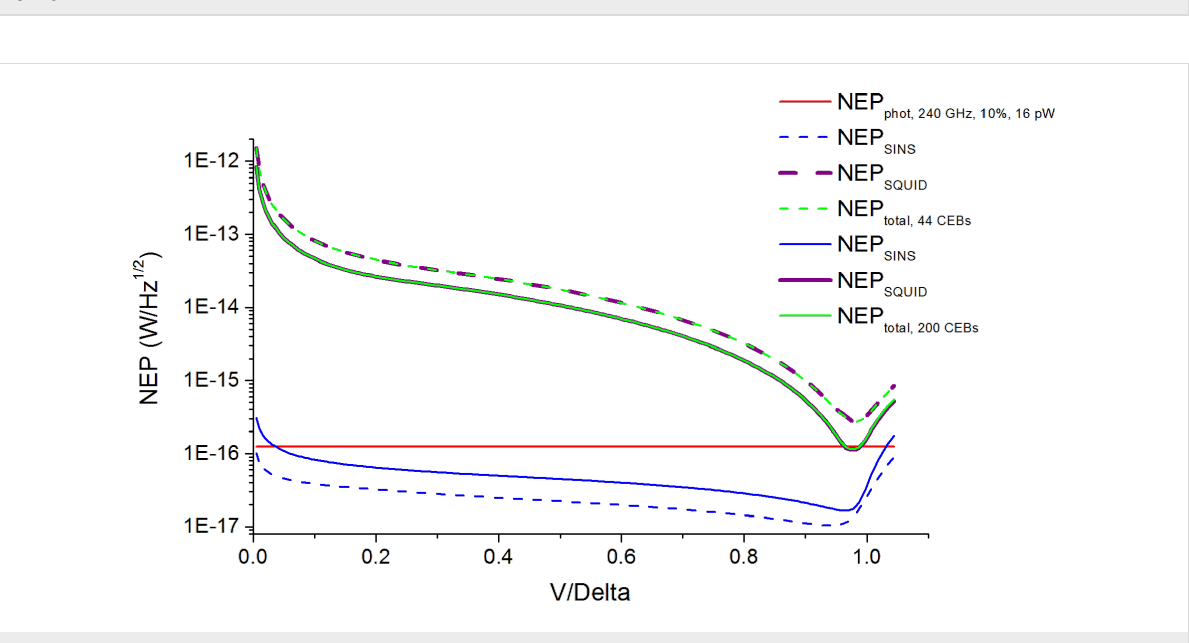
Figure 8: NEP estimations for the 210 GHz channel with 12.4 pW power load. Dashed curves are for 44 SINS CEBs; solid curves are for 200 SINS CEBs.